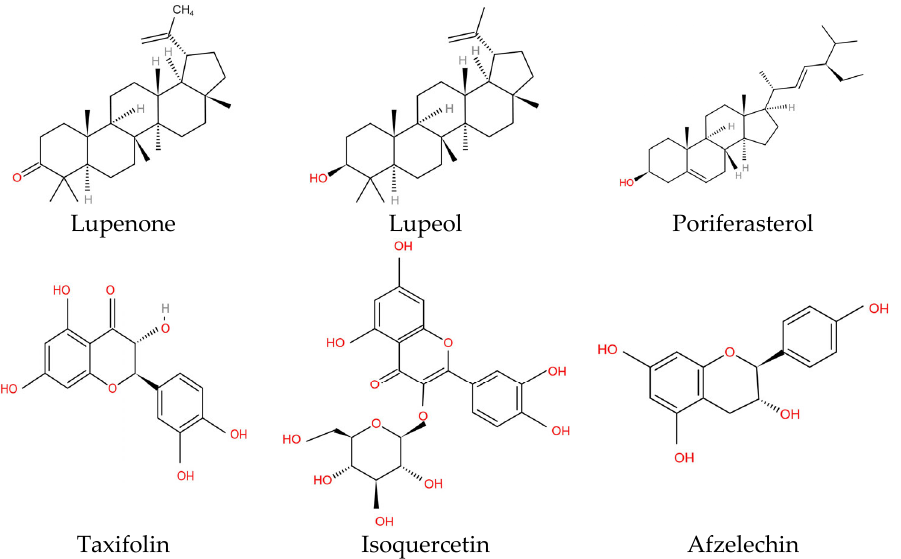
Figure 3. Structure of some major bioactive compounds of Acacia catechu [5,7,43]. Table 2. Major compounds, molecular formula, and classes of the compounds in Acacia catechu . Compounds Molecular Formula